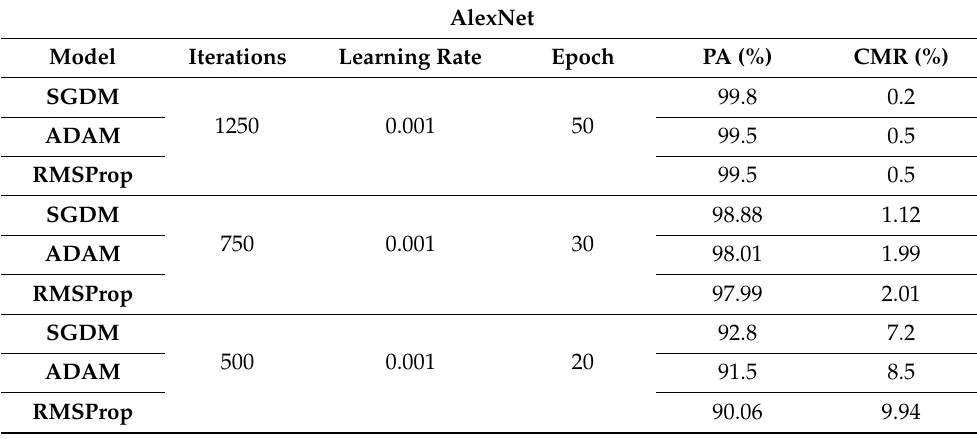
Table 2. Training results of AlexNet models with numerous learners.